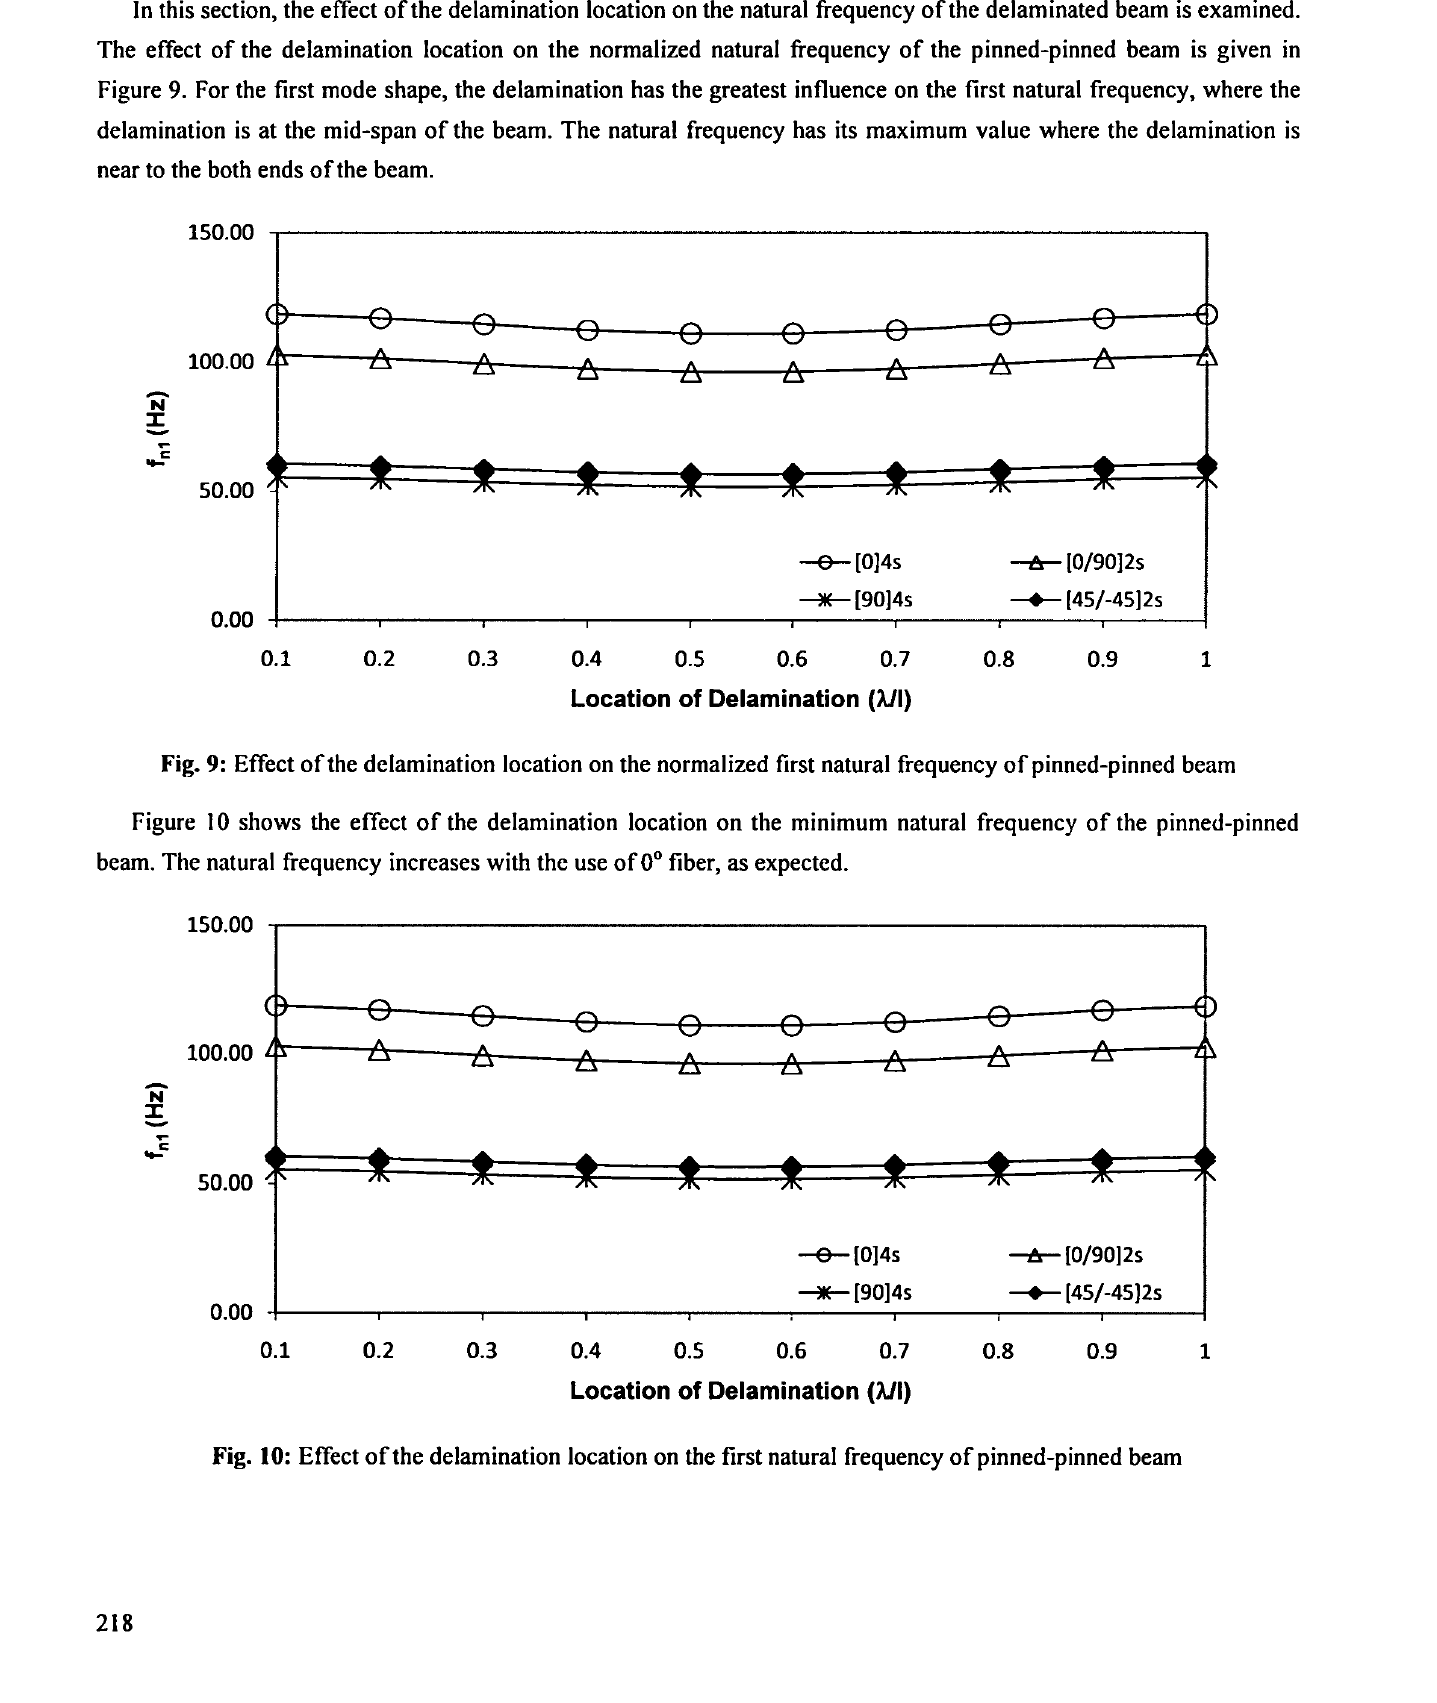
Fig. 10: Effect of the delamination location on the first natural frequency of pinned-pinned beam